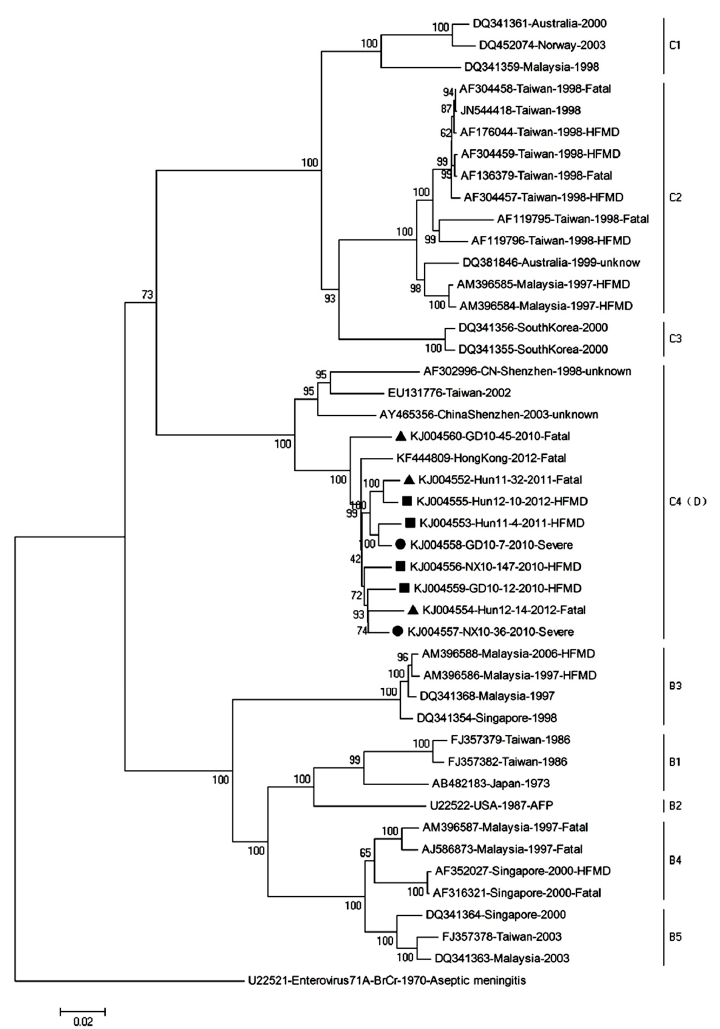
Figure 5. Phylogenetic analysis based on the complete genomes of the EV71 strains. Phylogenetic trees were generated by the neighbor-joining method with 1000 bootstraps from representative strains of known subgenotypes. The ▲ icon indicates fatal cases; ● indicates severe cases; ■ indicates mild hand, foot, and mouth disease (HFMD) cases. KJ004556 (NX10-147) and KJ004557 (NX10-36) were used to establish the mouse models of severe and mild EV71